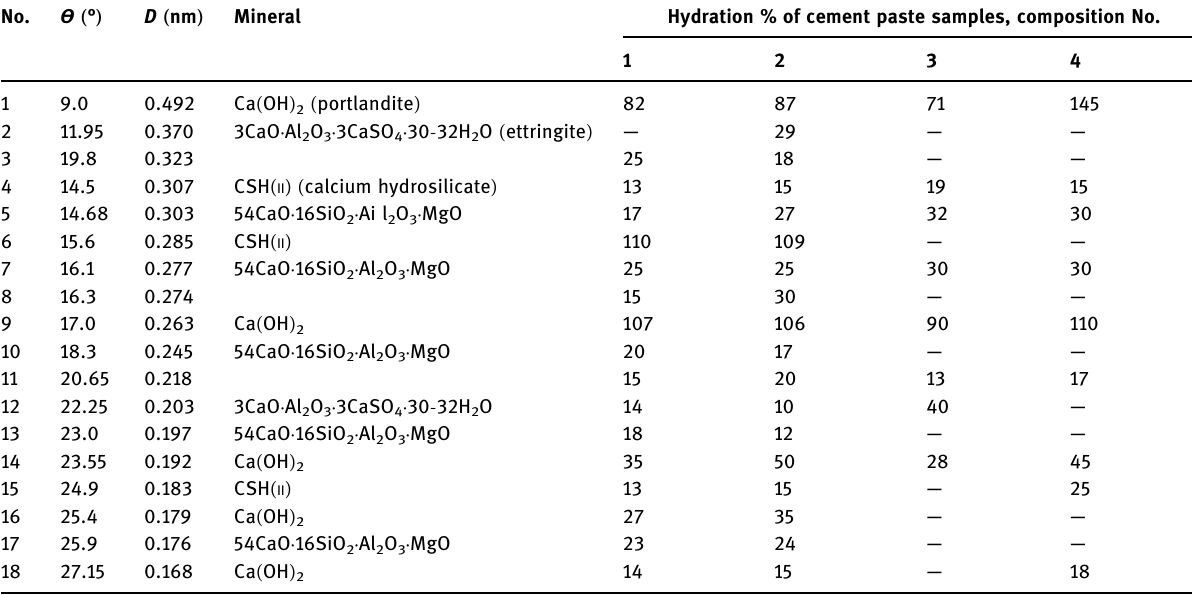
Table 11: Characteristics of X - ray patterns of cement paste samples No.